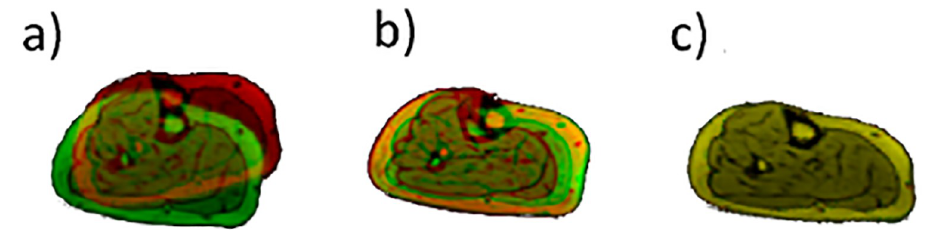
Fig 3. Sample registration outputs for qualitative interpretation. Registration results of images taken from the shank. The registration quality is visualised within these plots with poor, moderate, and flawless registrations shown in a, b, and c, respectively. Yellow colour represents well registered